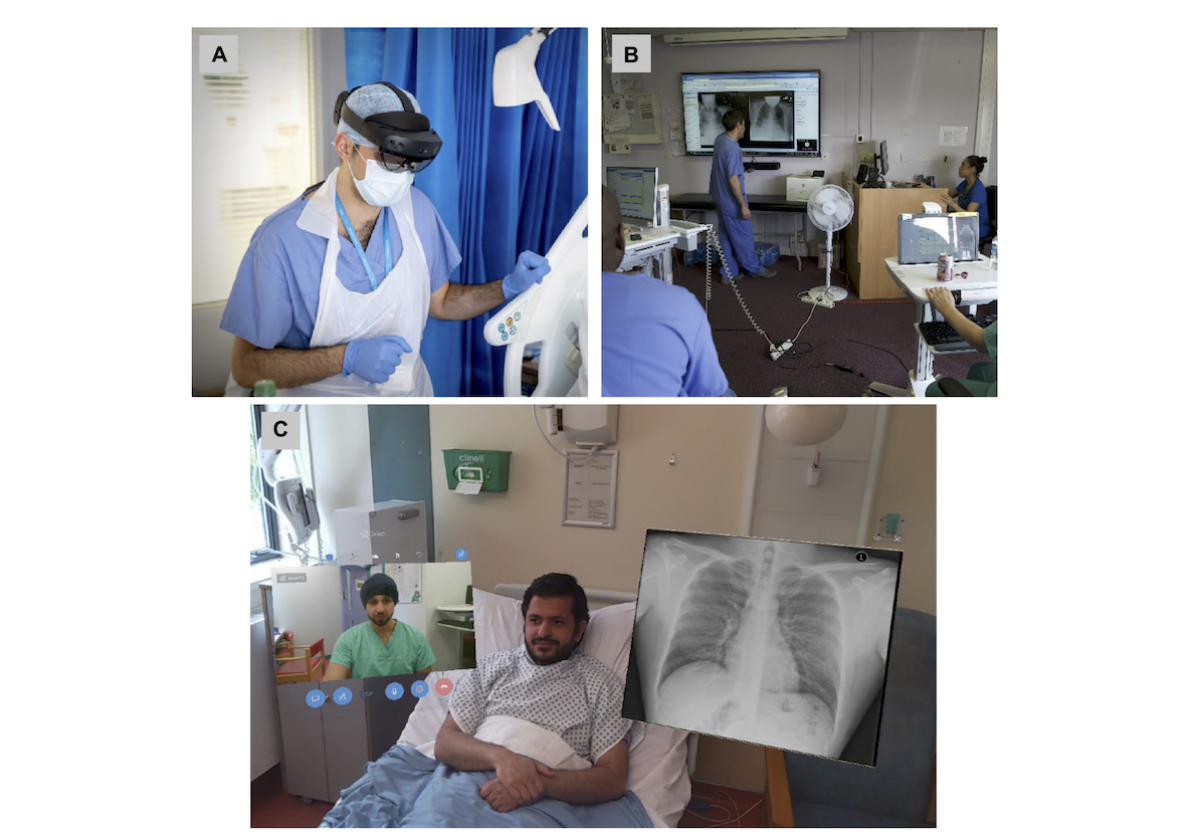
Figure 1. Images demonstrating the use and functionality of the HoloLens2 device. (A) View of end-user in personal protective equipment wearing the device. (B) View of remote clinical team engaging in clinical round from a safe location. (C) First-person view through the HoloLens2 showing the remote clinical team and relevant imaging placed in the user’s field of view as mixed-reality composites (image generated with study group to ensure the protection of patient privacy and